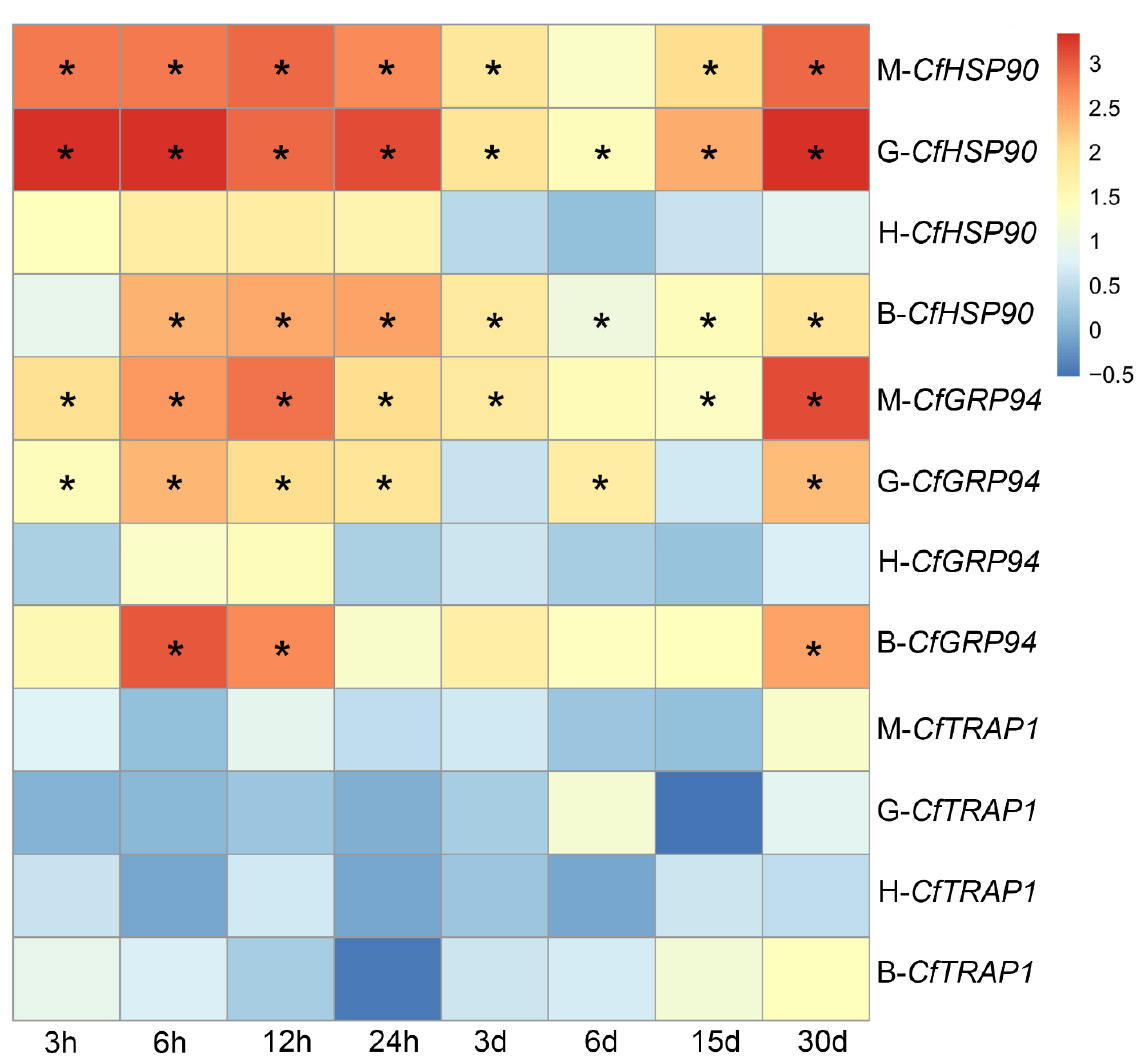
Figure 5. Expressions of CfHSP90 , CfGRP94 , and CfTRAP1 in the mantle (M), gills (G), heart (H), and blood (B) of C. farreri under heat stress. The expressions of CfHSP90s at 0 h are used as controls. Values marked with asterisks indicate statistically significant differences compared with control expression (* |log 2 FC| > 1 and FDR < 0.05).